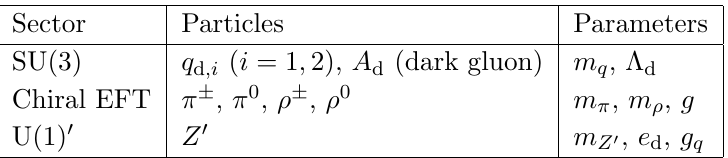
Table 1 . Overview of independent parameters in the